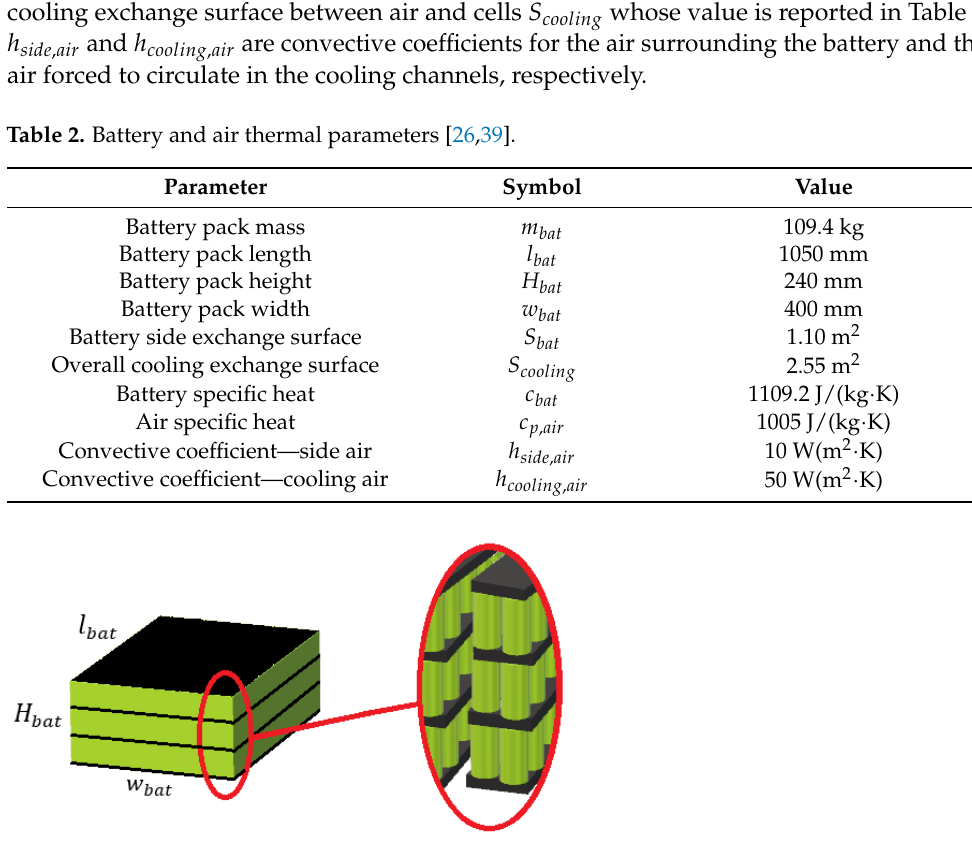
Figure 3. Schematic diagram of the arrangement of cells within the modeled battery pack.